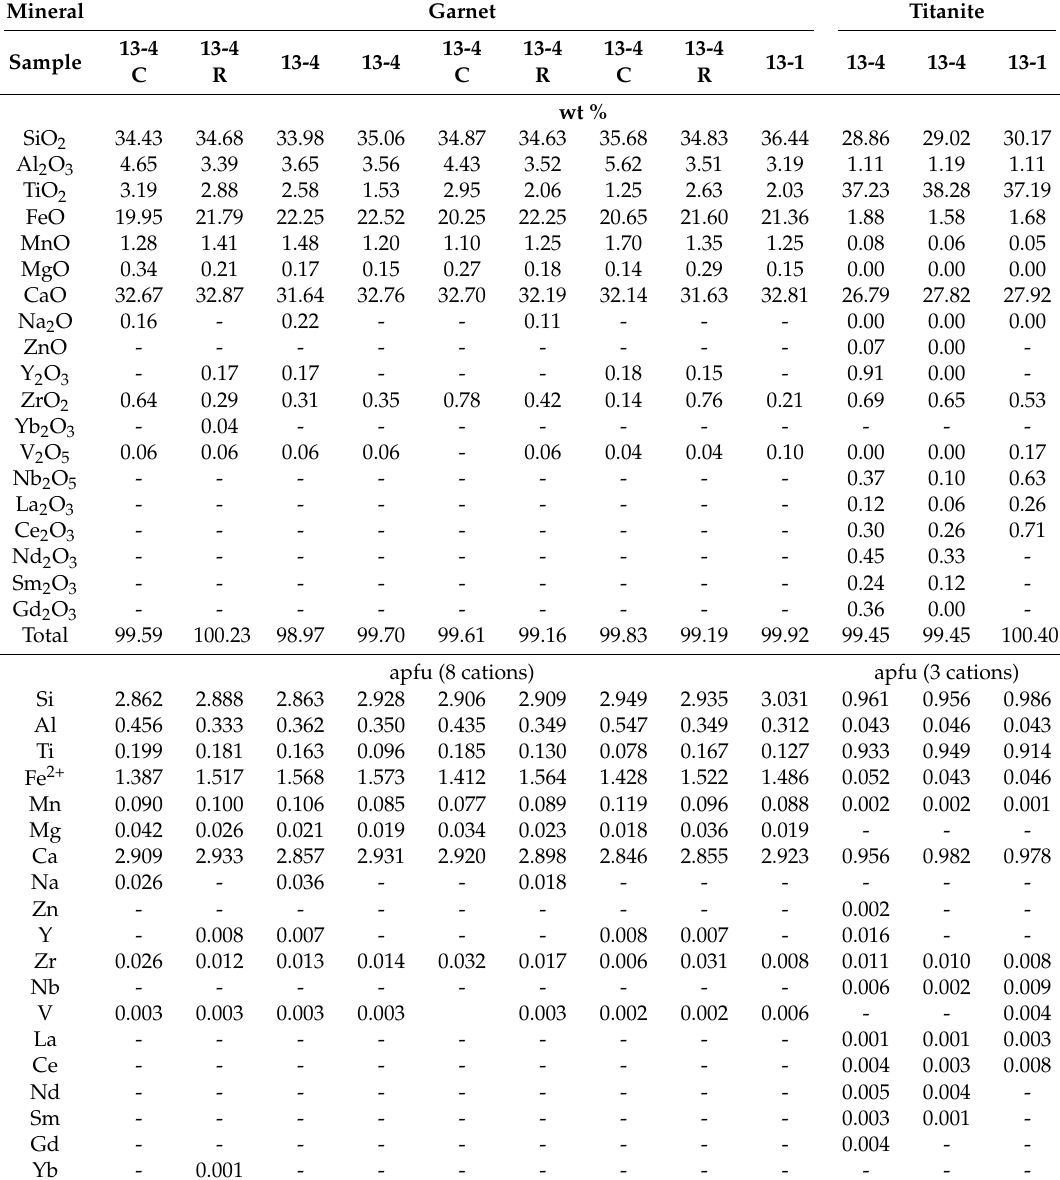
Table 3. Chemical analyses of garnet and titanite from Breivikbotn